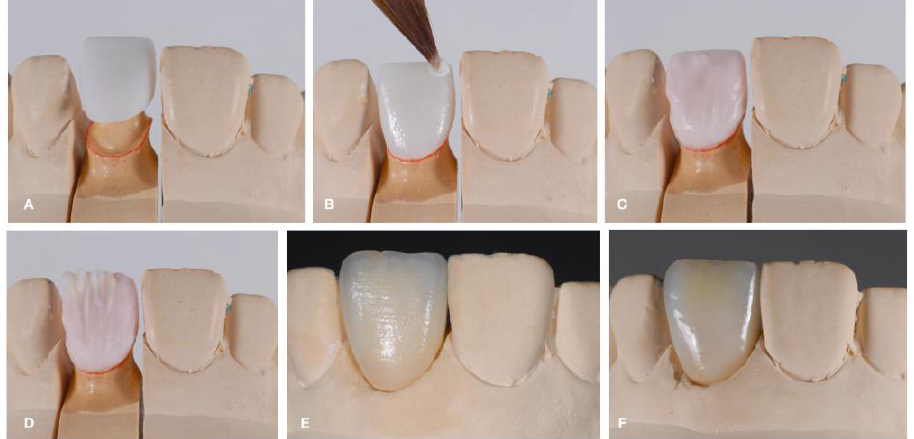
Figure 1. Layering technique. ( A ) Polycrystalline Framework; ( B ) Feldspathic ceramic build-up (wash bake); ( C ) Feldspathic ceramic build-up (intensive chrome + dentin); ( D ) Feldspathic ceramic build-up (enamel layer); ( E ) Feldspathic ceramic after firing; ( F ) Feldspathic ceramic after thermal and mechanical glaze.